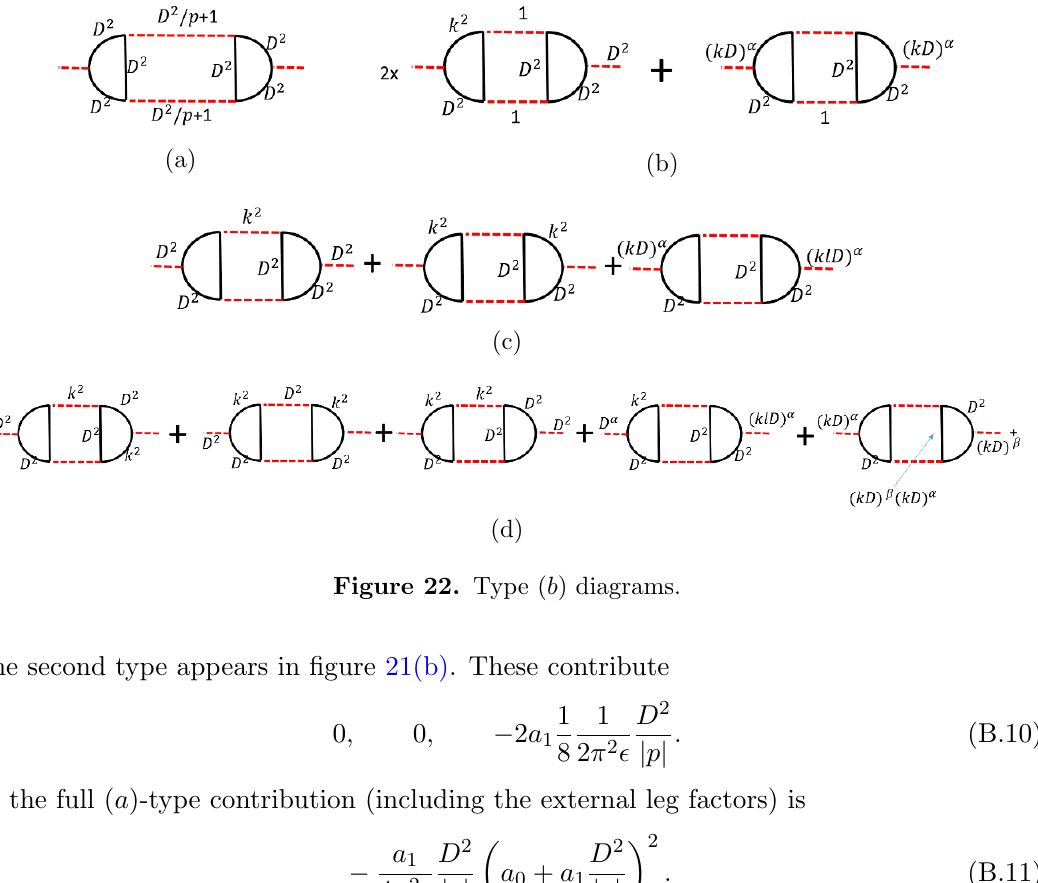
Figure 22. Type ( b )